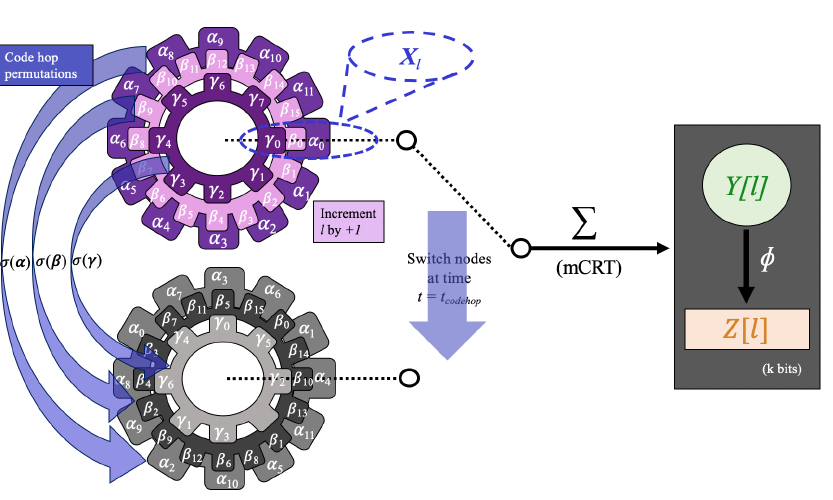
Figure 14. An example of code hopping with three different sets of parameters, where α , β , and γ represent the top clockwise orderings α 1 , α 2 , . . . α 9 ,